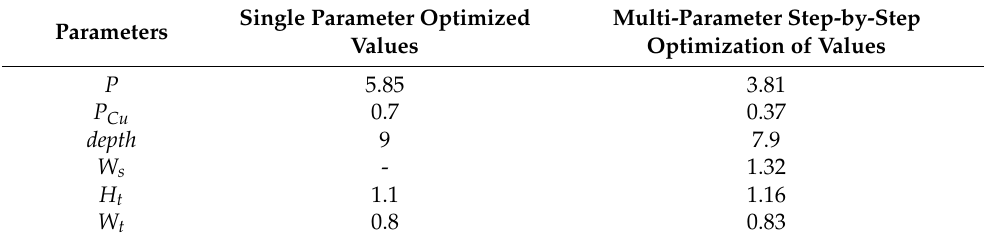
Table 5. The results of multi-parameter step-by-step